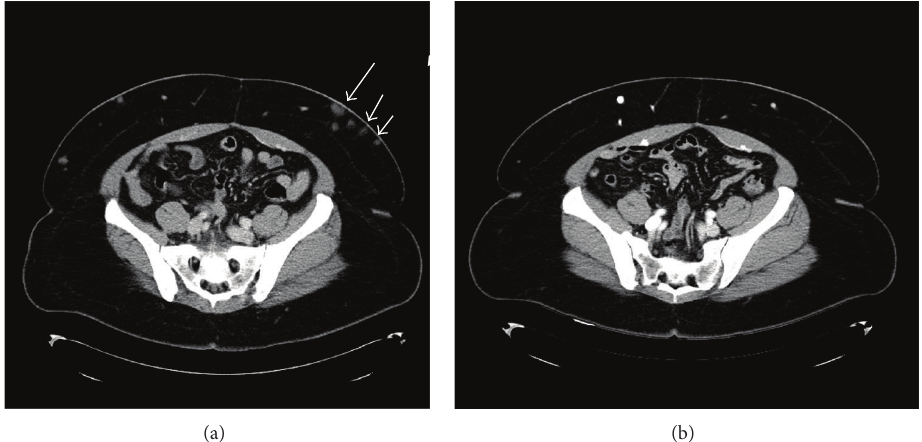
Figure 1: Case 1: CTs of the abdomen illustrating (a) subcutaneous nodules prior to initiation of denileukin diftitox and (b) resolution of the subcutaneous nodules after treatment with denileukin